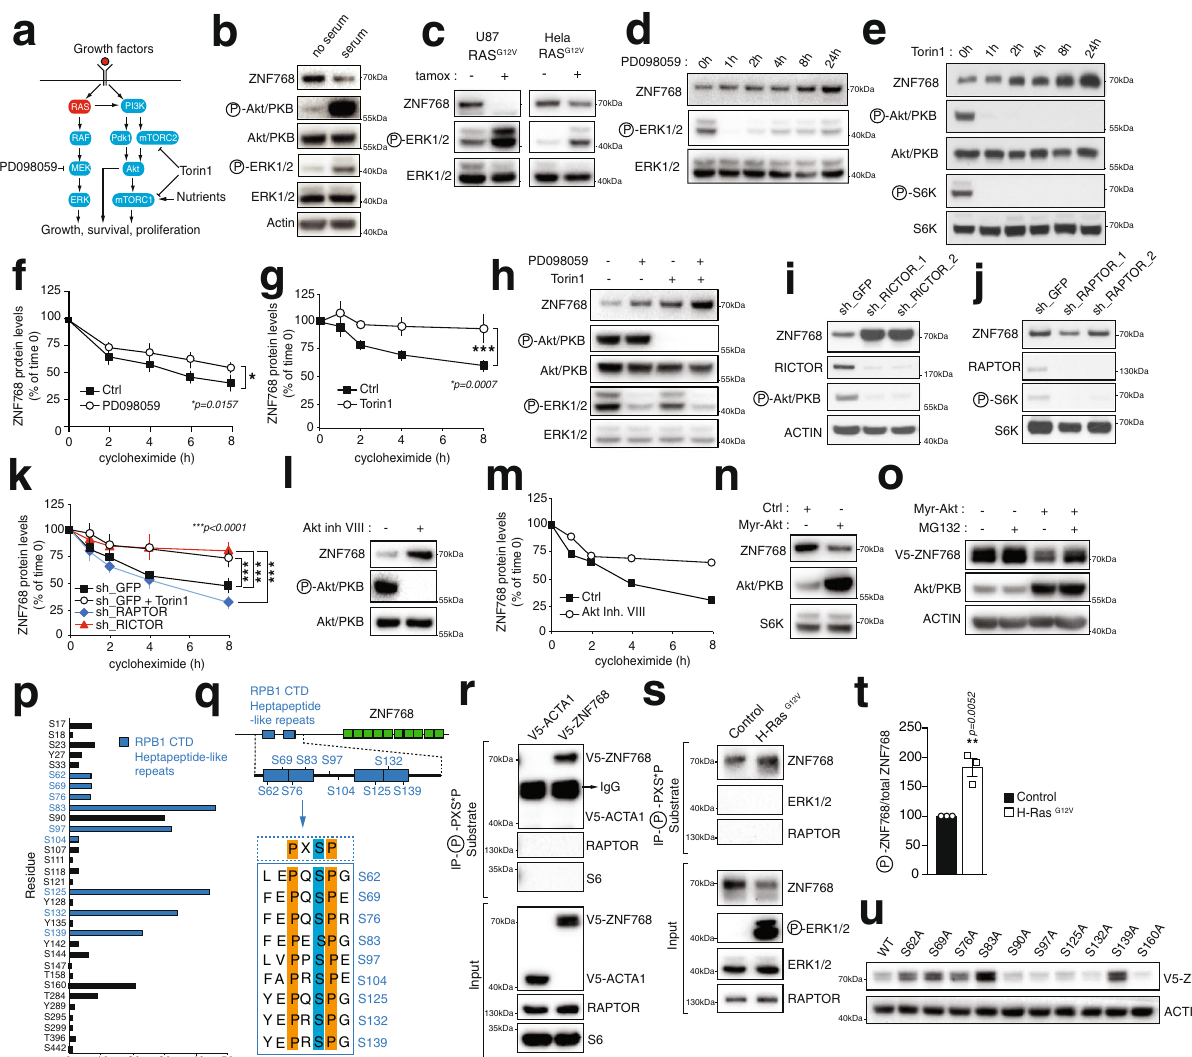
Fig. 1 Identi fi cation of ZNF768 as a phosphoprotein destabilized upon RAS activation. A Overview of the RAS signaling pathway. B RPE cells were incubated with or without 10% serum for 2 h and western blots were performed. C Cells were transduced to overexpress RAS G12V with a